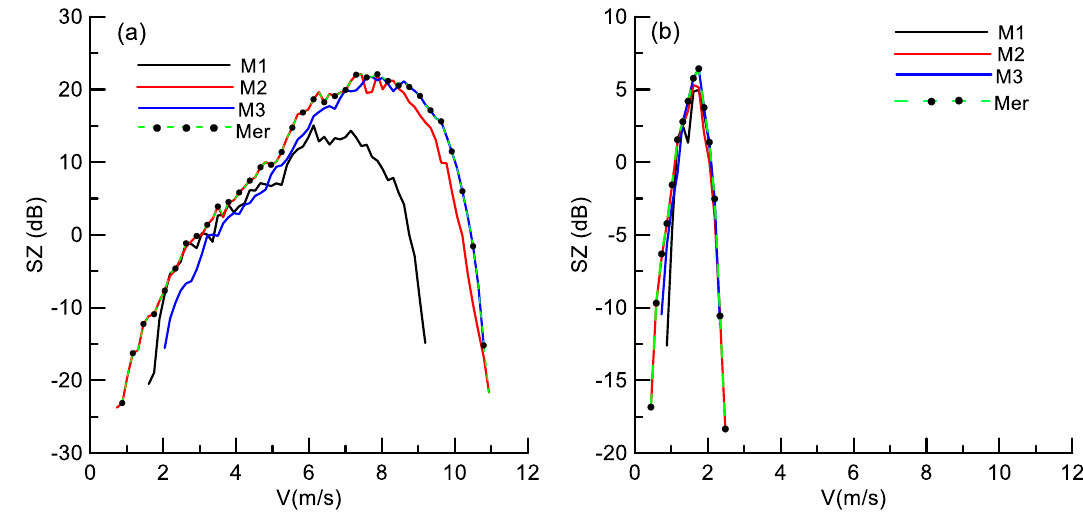
Figure 4. SZ1, SZ2, and SZ3 for ( a ) liquid hydrometeors at 2.7 km, and ( b ) solid hydrometeors at 6.6 km. The merged reflectivity and velocity (marked with “Mer”) is also